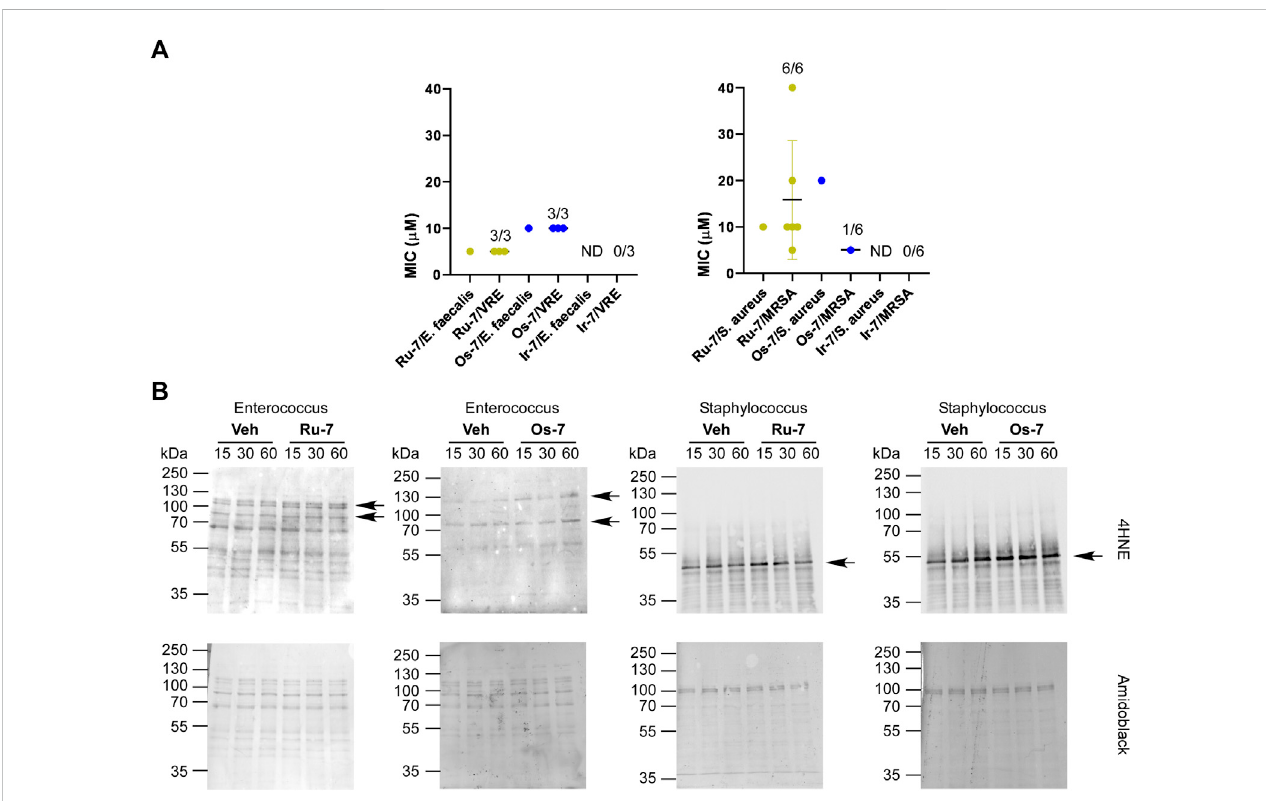
FIGURE 10 (A) Ru-7 , Os-7 and Ir-7 complexes exert bacteriostatic activity against reference strains and clinical VRE and MRSA isolates. The MIC values of the complexesweredeterminedagainstthereferencestrainsof S.aureus (ATCC29213)and E.faecalis .(ATCC29212)andagainstclinicalVREandMRSAisolatesby microdilution assays (repeated at least twice in duplicates) as described in Materials and Methods. The numbers indicate how many isolates were susceptible tothecompoundoutofthosetested;i.e.,1/6standsfor1isolatewassusceptibleoutof6tested. (B) Theindicatedreferencestrainsweretreatedwiththe indicatedcomplexes( Ru-7 at5 μ M, Os-7 at10 µMon Enterococcusfaecalis , Ru-7 at10 μ M, Os-7 at20 µMon Staphylococcusaureus )forthetimeindicated. Cells were harvested and lysed. Cellular proteins was separated on a 10% SDS-PAGE gel and were blotted. Blots were probed with 4HNE antibody (top blot), the lower blot was stained with amido black. Arrows point at band of interest. Experiments were repeated three times and a representative blot is shown. On the blots brightness and contrast were adjusted. Abbreviations: MRSA — methicillin-resistant Staphylococcus aureus, VRE — vancomycin-resistant Enterococcus, ND — not detected, MIC > 40 μ M, Veh —